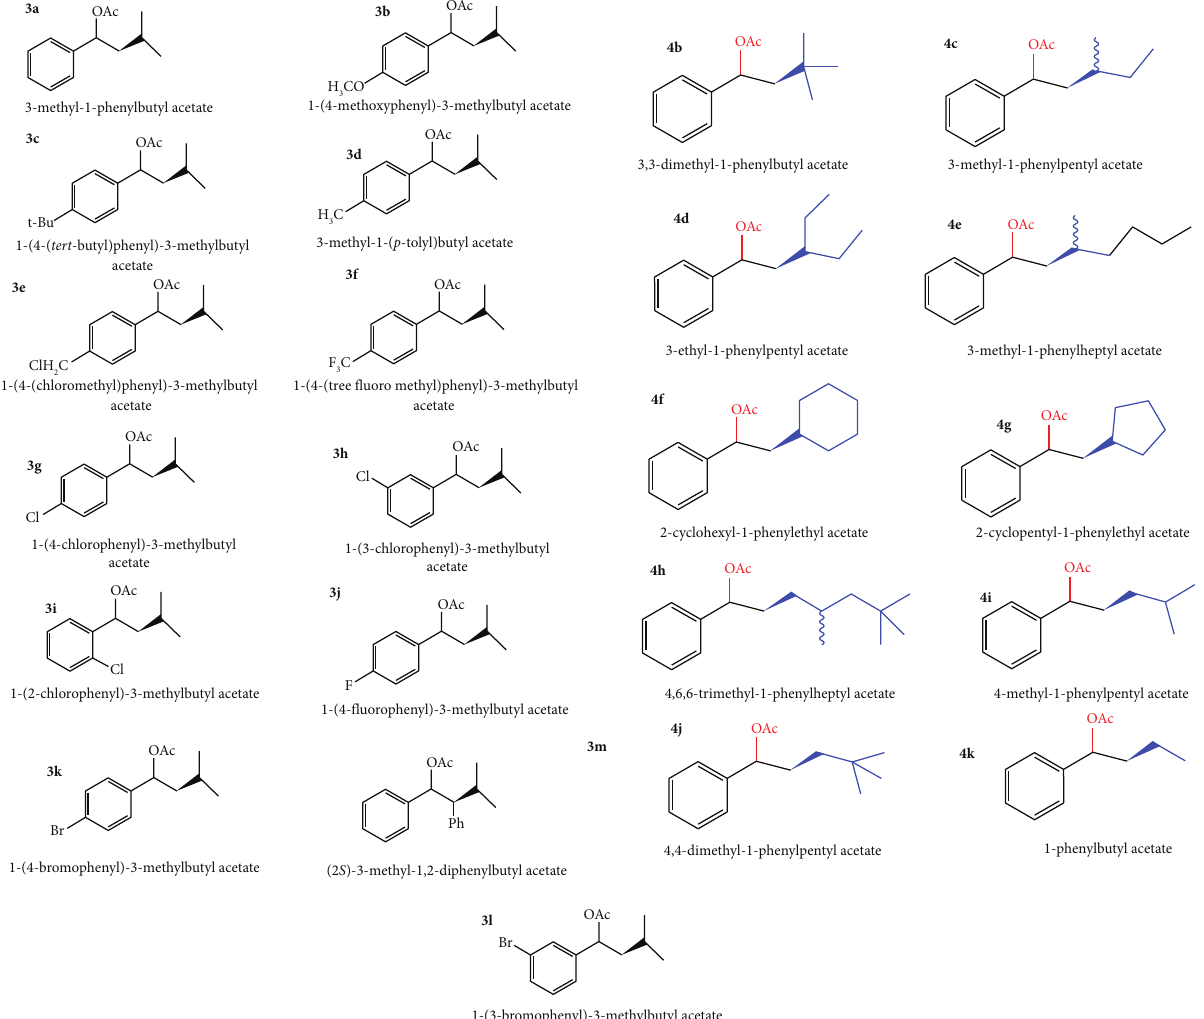
Figure 3: Stable product reaction of styrene derivatives with aldehyde